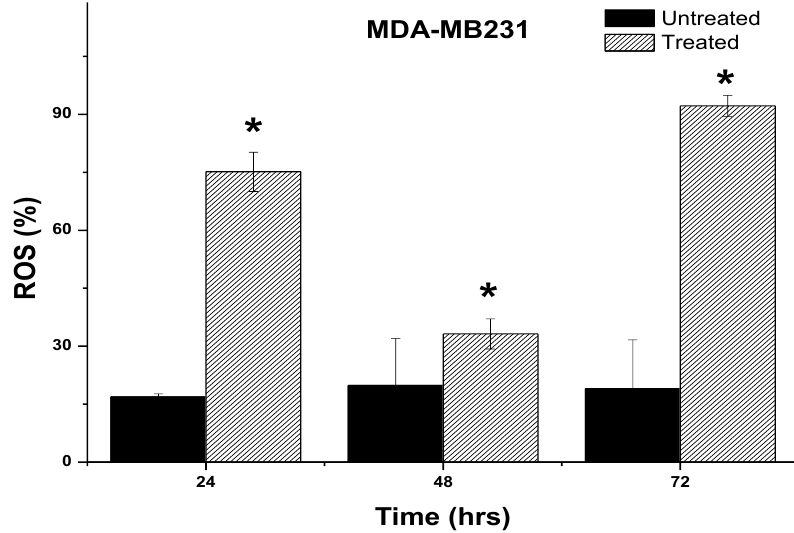
Figure 23. Reactive oxygen species for MDA-MB-231 cells after treatment with 7-geranyloxycinnamic acid at 24, 48 and 72 h. Error bar represents mean ± standard deviation. * Significantly ( p < 0.05) different from control.